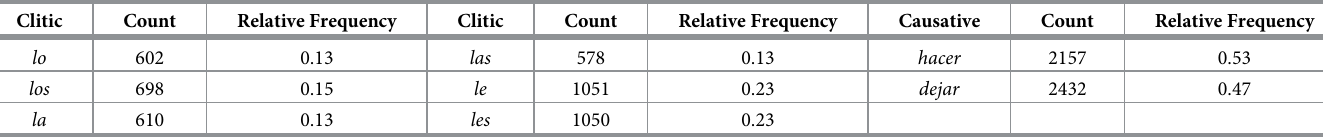
Table 3. Raw counts and relative frequencies of each clitic form and causative verb in the final dataset.